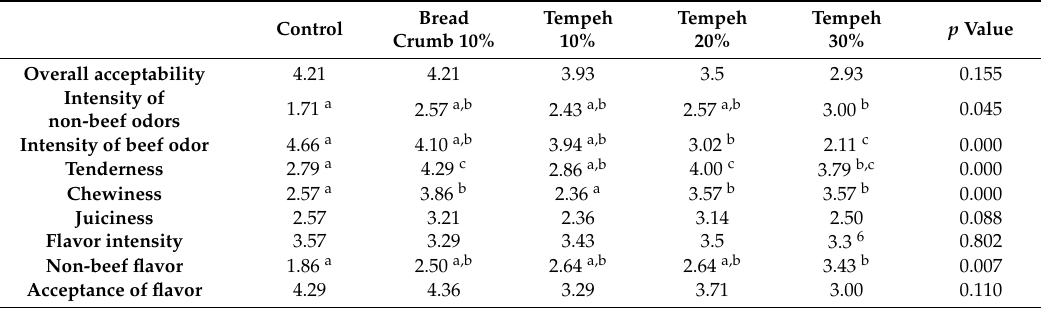
Table 4. Mean scores for sensory attributes for five beef patties substituted by tempeh at di ff erent levels in the pilot sensory study. The patties were evaluated by a small number of panelists ( n = 14). a–c Within each row, means that do not share the same letters are significantly di ff erent ( p < 0.05). Bread Tempeh Tempeh Tempeh p Value Control Crumb 10% 10% 20% 30% Overall